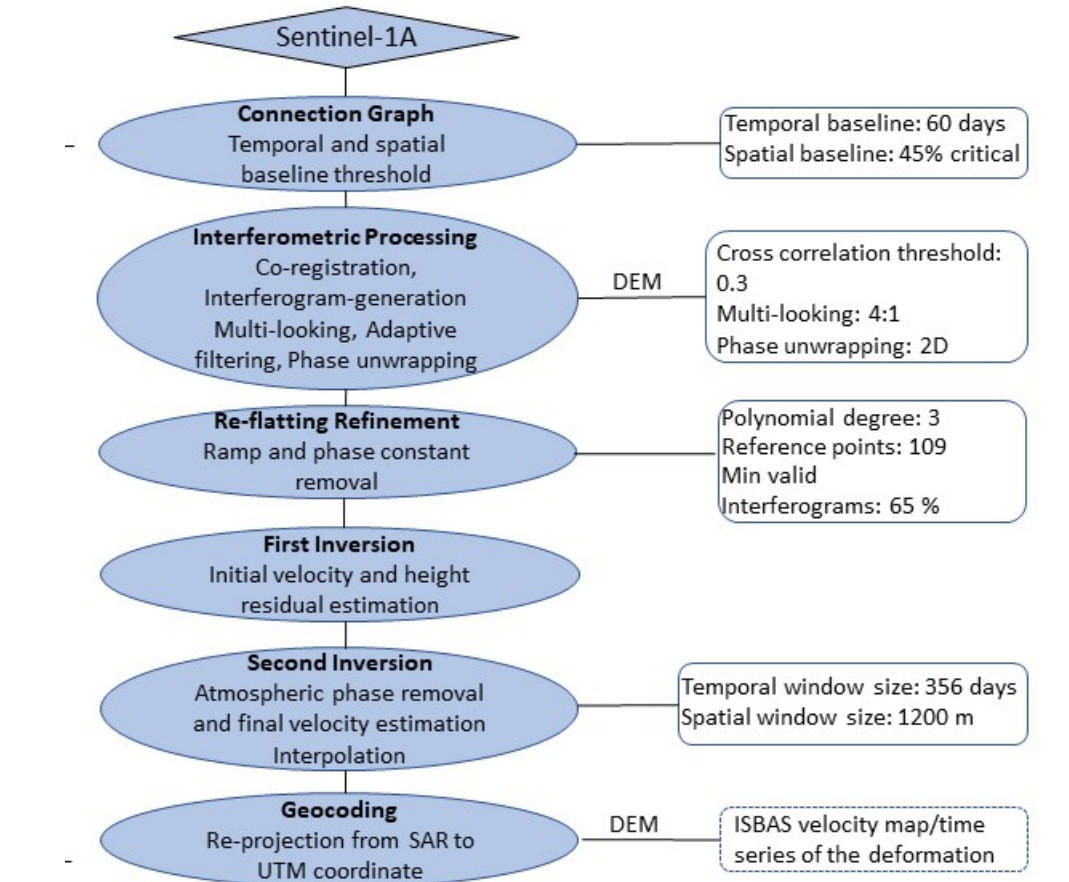
Figure 3. Workflow of the Intermittent Small Baseline Subset (ISBAS) processing for the bluff deformation analysis following procedures described in [71]. The workflow displays the parameters (dashed boxes), the processing steps (solid circles with black background), and the operations (solid rectangles with grey background). UTM refers to Universal Transverse Mercator.